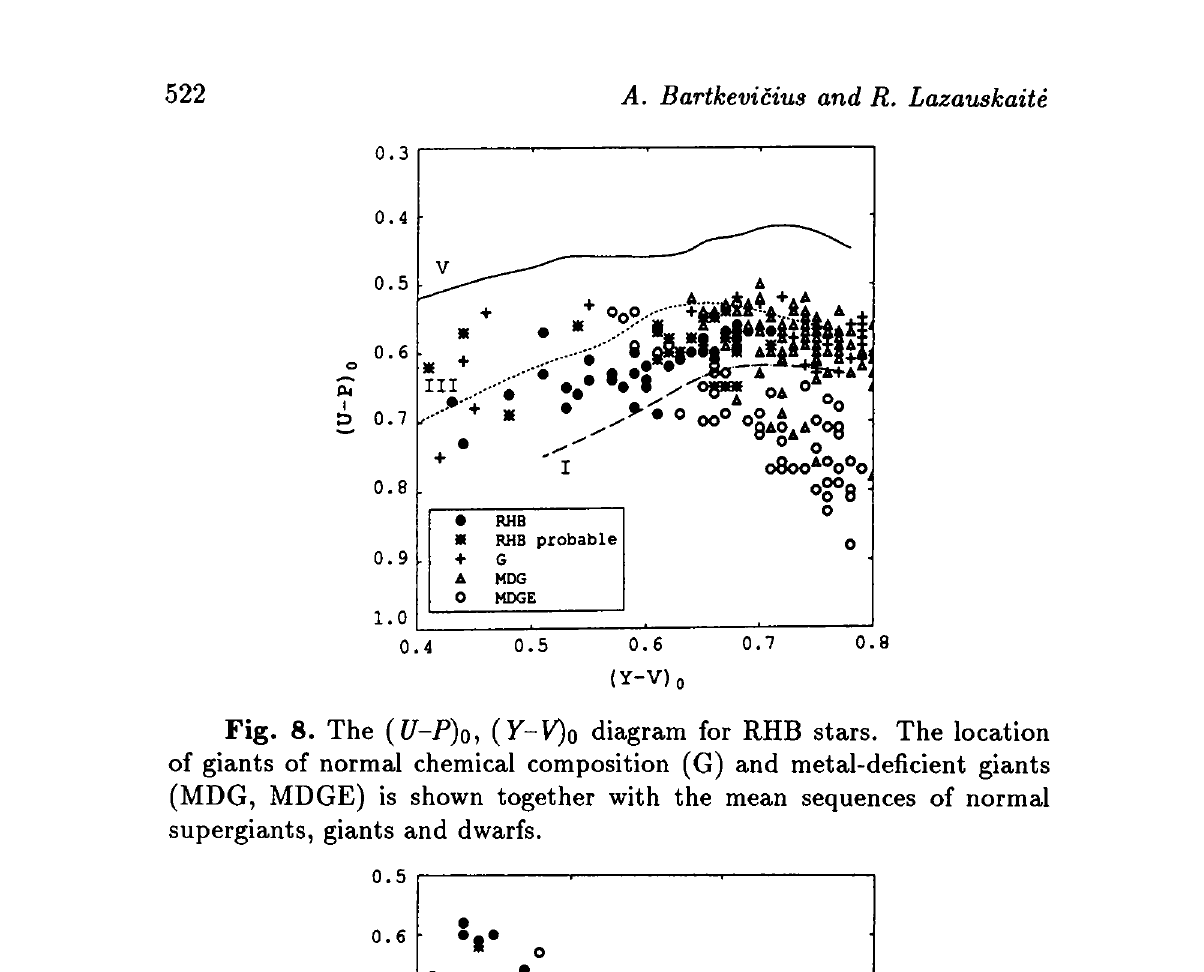
Fig. 8. The (U-P) , (y~V )o diagram for RHB stars. The location 0 of giants of normal chemical composition (G) and metal-deficient giants (MDG, MDGE) is shown together with the mean sequences of normal supergiants, giants and dwarfs.